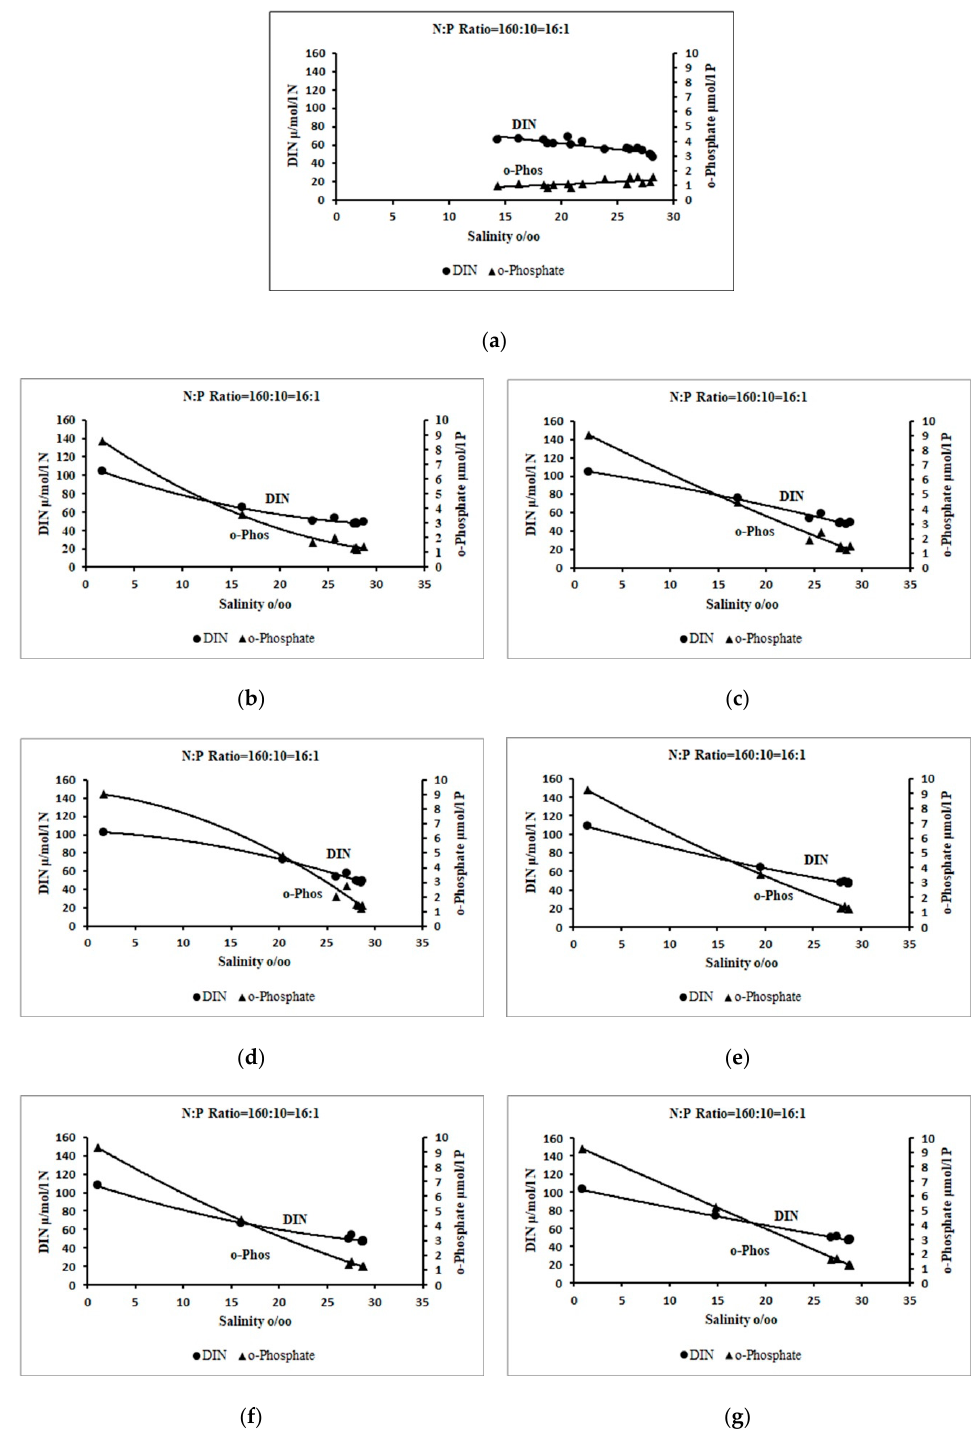
Figure 10. Overlay chart of mean salinity and nutrients (including DIN and o -phosphate) of representative vertical lines for the estuarine systems before and after the construction of the proposed sluice in Jiaojiang River estuary. Notes: In this figure, µ mol / L N = [(mg / L N) × 1000] / 14, µ mol / L P [(mg / L P) × 1000] / 31, where 14 and 31 are the relative atomic masses of N and P, respectively. ( a ) Initial state of estuary and coastal water; ( b ) discharged with flow of 1500 m 3 / s during spring tide; ( c ) discharged with flow of 3000 m 3 / s during spring tide; ( d ) discharged with flow of 5000 m 3 / s during spring tide; ( e ) discharged with flow of 1500 m 3 / s during neap tide; ( f ) discharged with flow of 3000 m 3 / s during neap tide; ( g ) discharged with flow of 5000 m 3 / s during neap